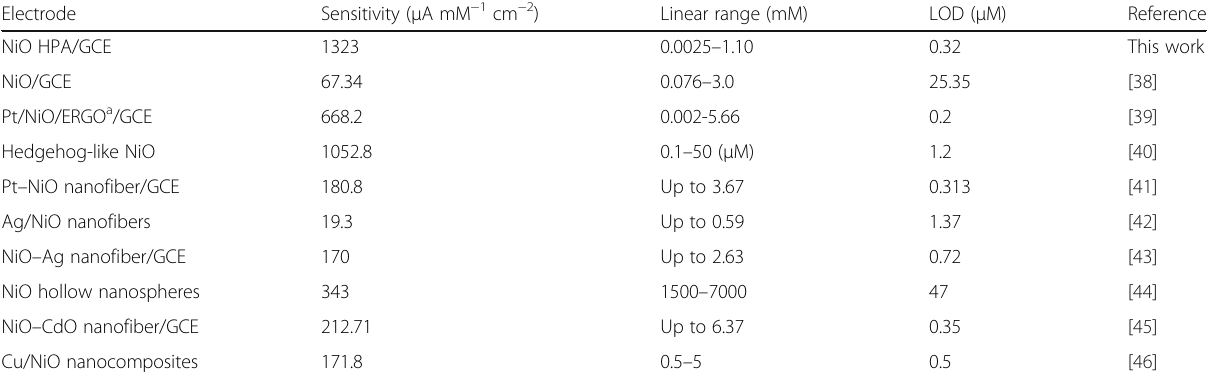
Table 1 Comparison of researched electrode with reported nonenzymatic glucose sensors based on NiO Electrode